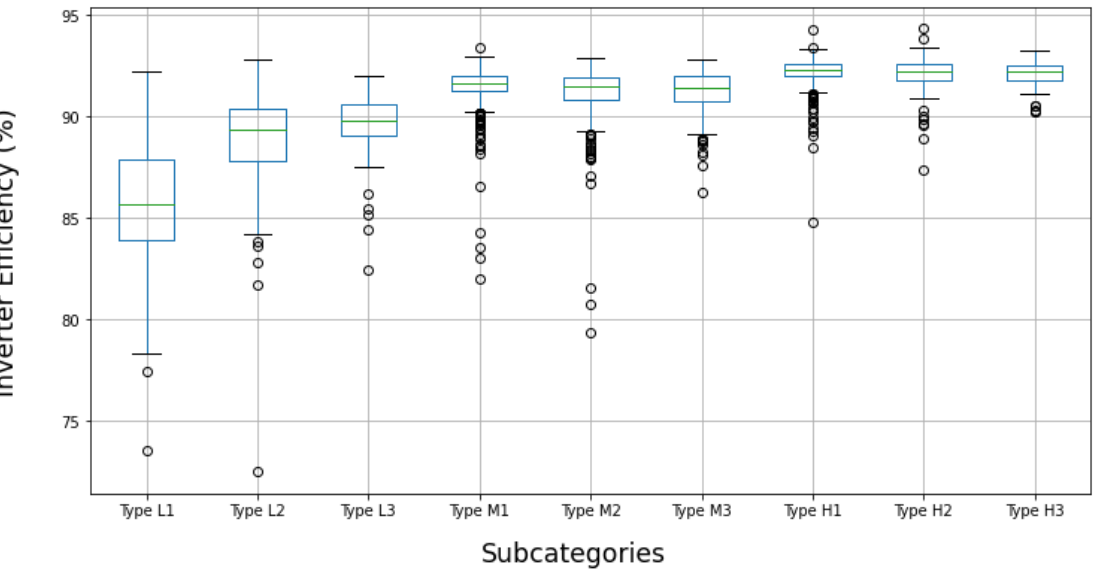
Figure 21. Inverter efficiency in the clusters L1, L2, L3, M1, M2, M3, H1, H2 and H3.